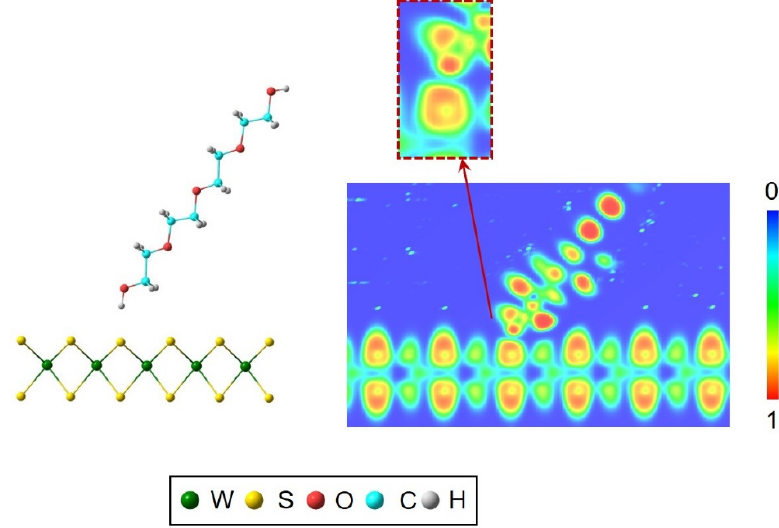
Figure 3. Electron localization function (ELF) contour plots for structure 2 .